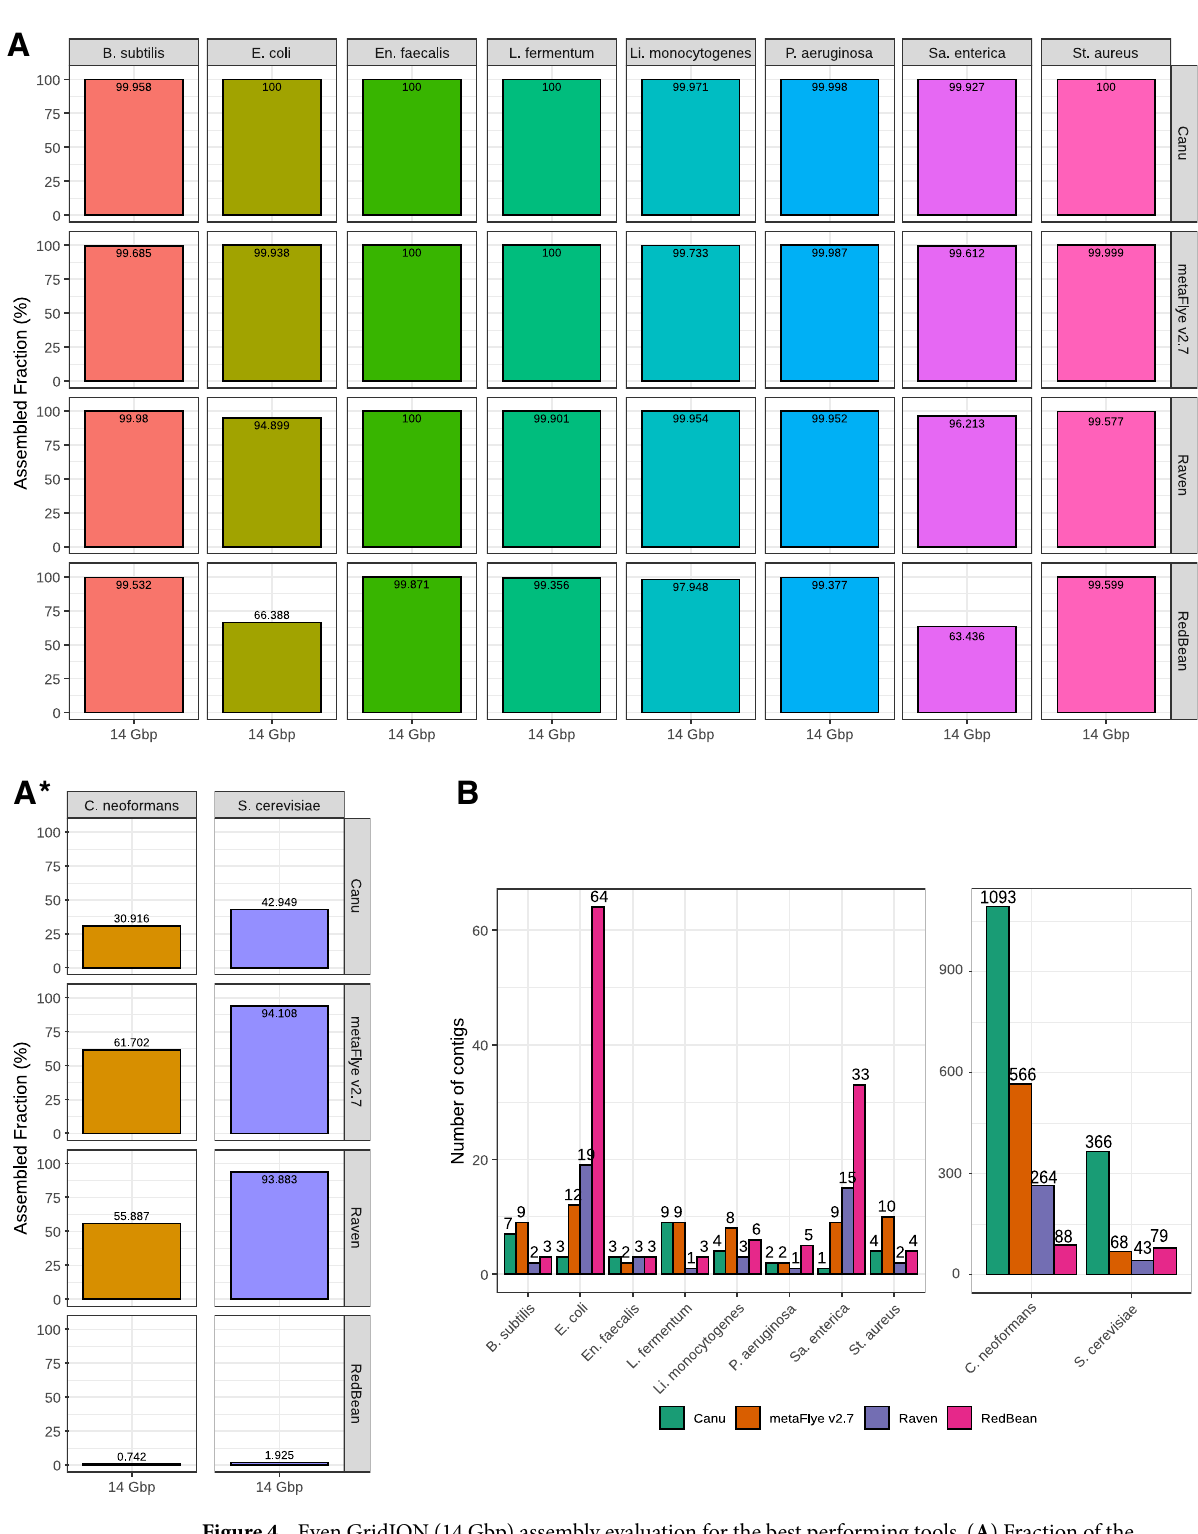
Figure 4. Even GridION (14 Gbp) assembly evaluation for the best performing tools. ( A ) Fraction of the genome covered by draft assemblies; ( B ) number of contigs for each